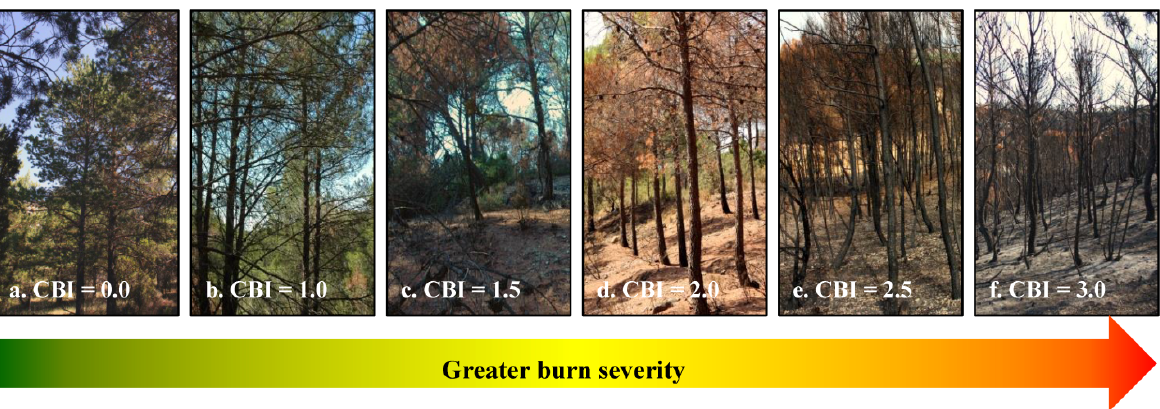
Figure 4. Partial views of different Composite Burn Index (CBI) plots depending on its burn severity value. Each photograph corresponds to the point cloud showed in the Figure